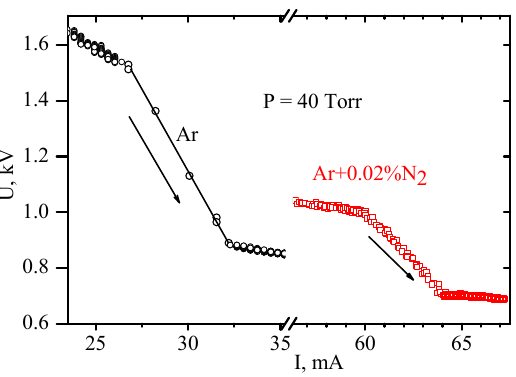
Figure 10. Volt–amp characteristics for Ar and Ar-N 2 mixture in a region of constricting [16]. (© IOP Publishing. Reproduced with permission. All rights reserved.)